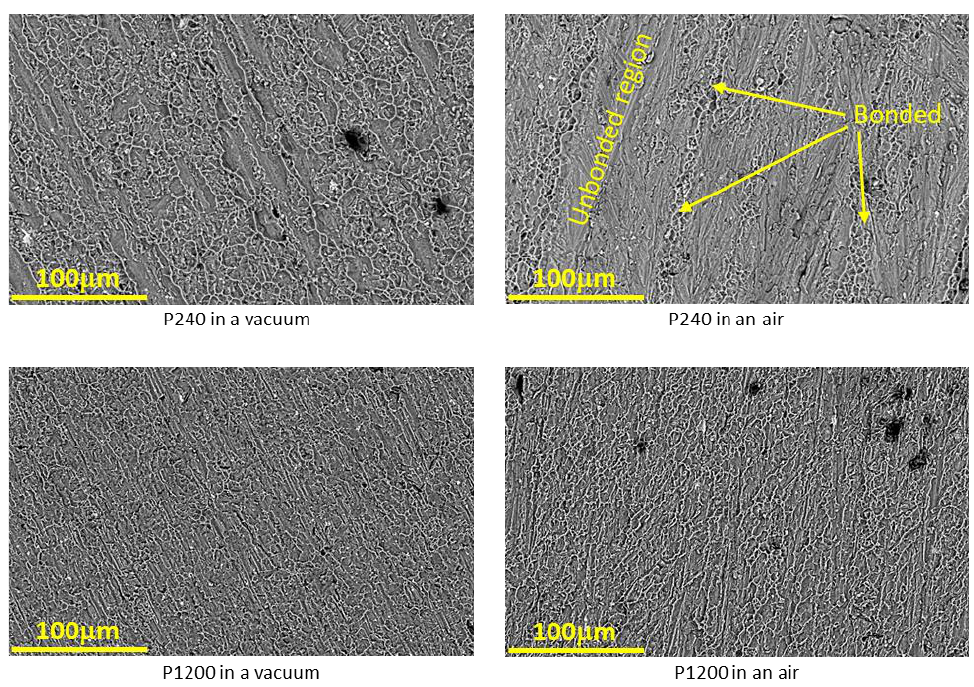
Figure 18. Fracture topography after tensile test of AA6061–AA1050 pairs with different surface roughness, also showing bonded and unbonded regions on the fracture surface.